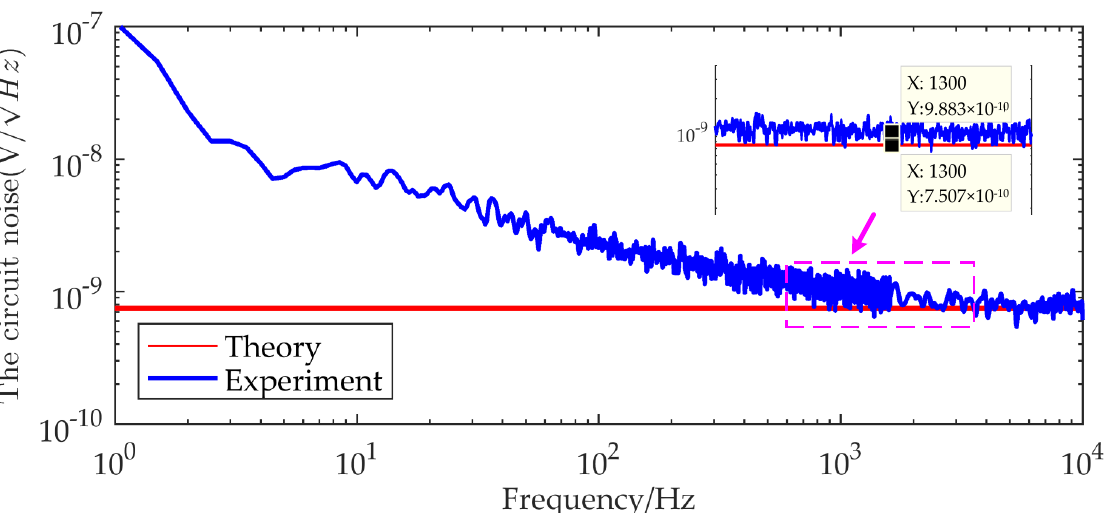
Figure 12. Comparison of measured noise data and theoretical calculated values of IF3602 low-noise amplifier circuit.